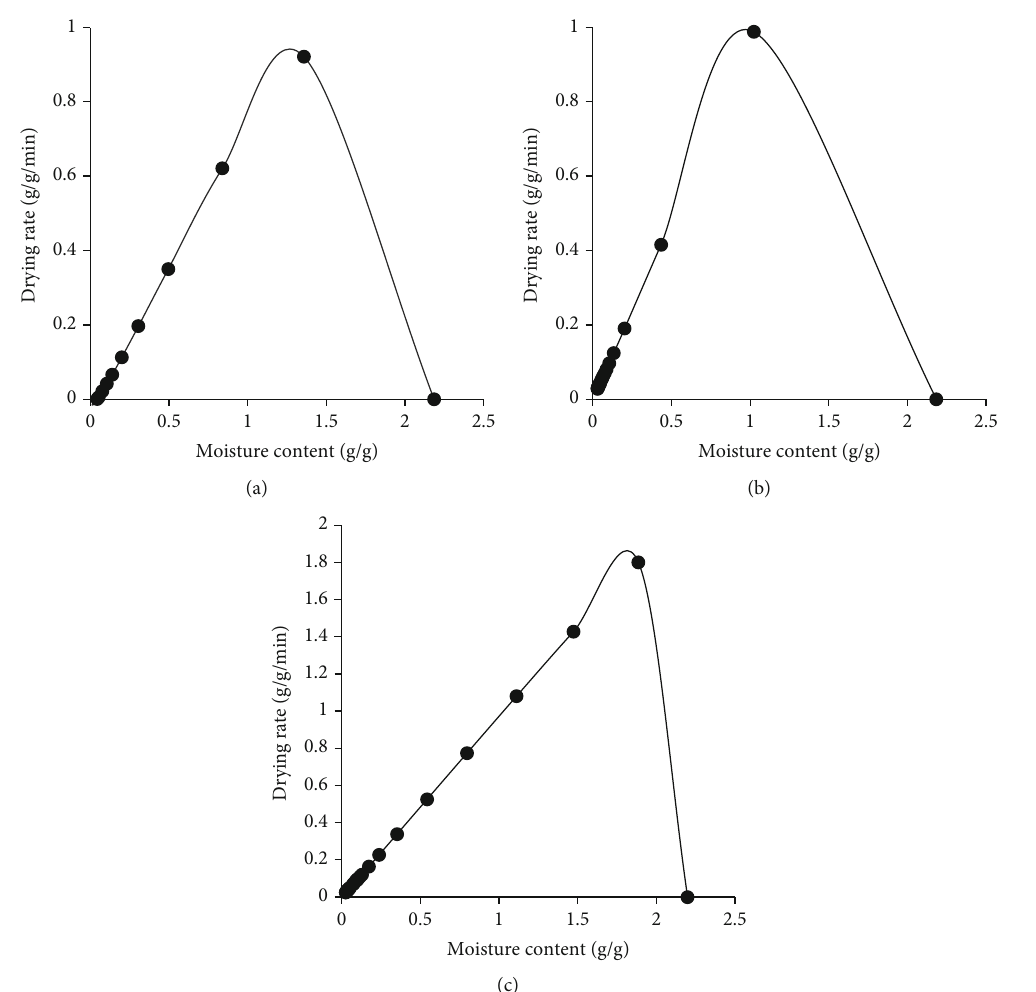
Figure 3: Krischer curves for refractance window drying (a), oven drying (b), and solar drying